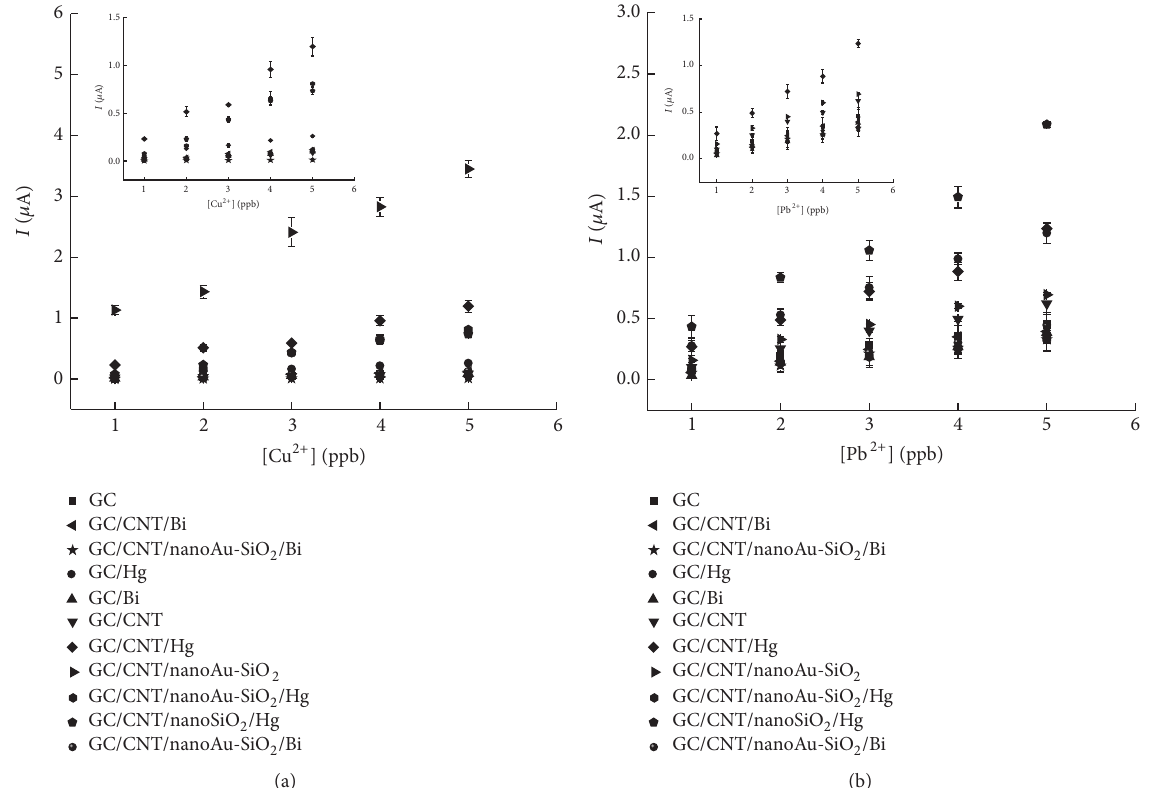
Figure 2: Graph comparing analytical calibration curves for analysis of Pb 2+ and Cu 2+ using glassy carbon electrode and its respective mobilizations with nanomaterials and metal films using Method 1. Simultaneous determination of ions Pb 2+ and Cu 2+ by DPASV GC/CNT/nanoAu-SiO 2 (a) voltammogram and (b) analytical calibration curve for Pb 2+ , 𝑟 = 0.9827 , 𝐼 = −2.2917 + 1.8224 [Pb 2+ ], and, for Cu 2+ , 𝑟 = 0.9571 , 𝐼 = −0.2395 + 0.2215 [Cu 2+